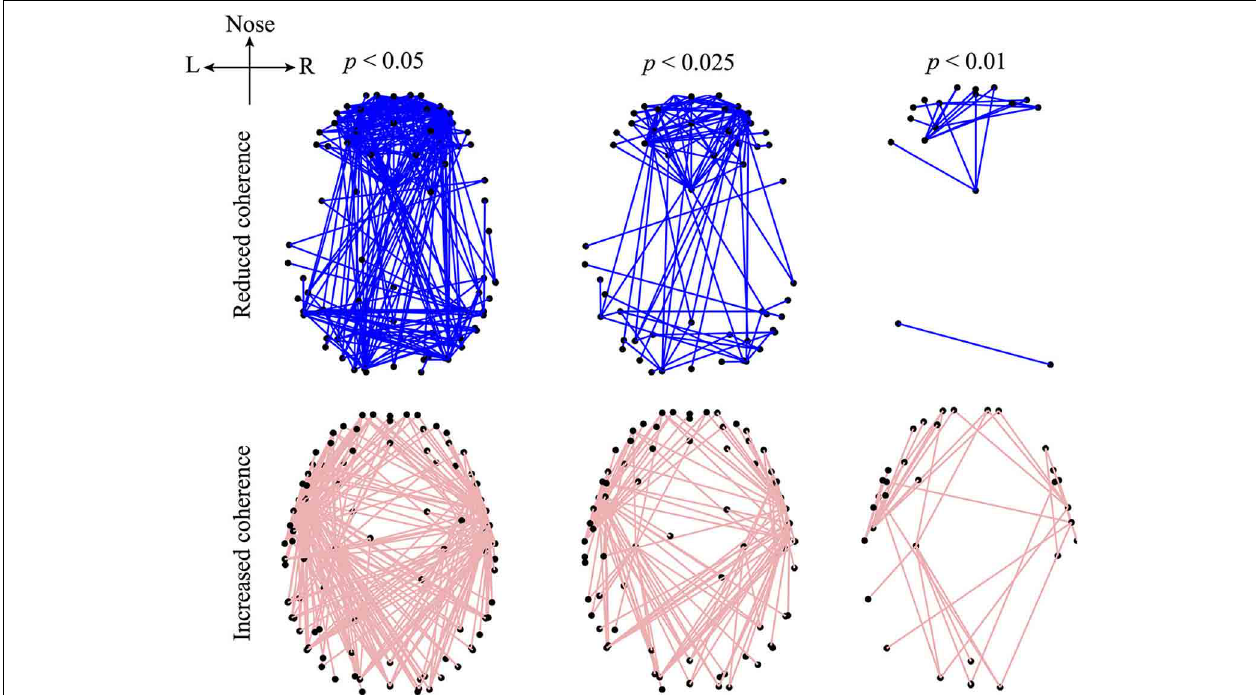
FIGURE 4 | Graphical representations of the electrode pairs with significantly reduced (upper panel) or increased (lower panel) phase-coherence of the sub-delta band (0.05–1.5Hz) EEG induced by propofol anesthesia. EEG data (128-channel recording) were recorded from 5 subjects and processed by the EEG_coherence algorithm diagrammed in Figure 3 . The electrode pairs with significant ( p < 0 . 05) changes in phase coherence are connected with lines. The electrode-pair map is represented in